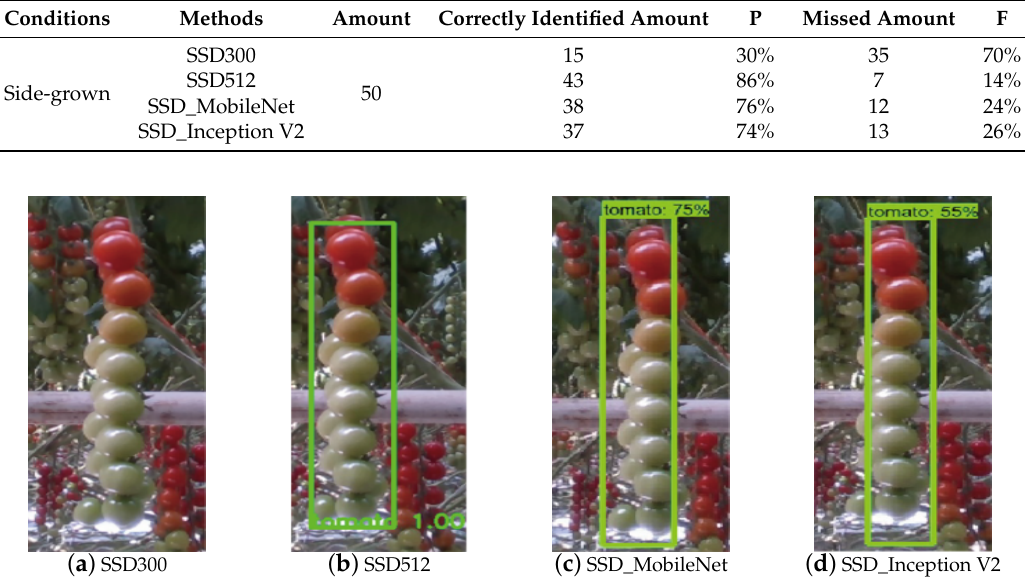
Figure 8. The detection results of side-grown cherry tomatoes. ( a ) the result of SSD300 model, ( b ) the result of SSD512 model, ( c ) the result of SSD_MobileNet model and ( d ) the result of SSD_Inception V2